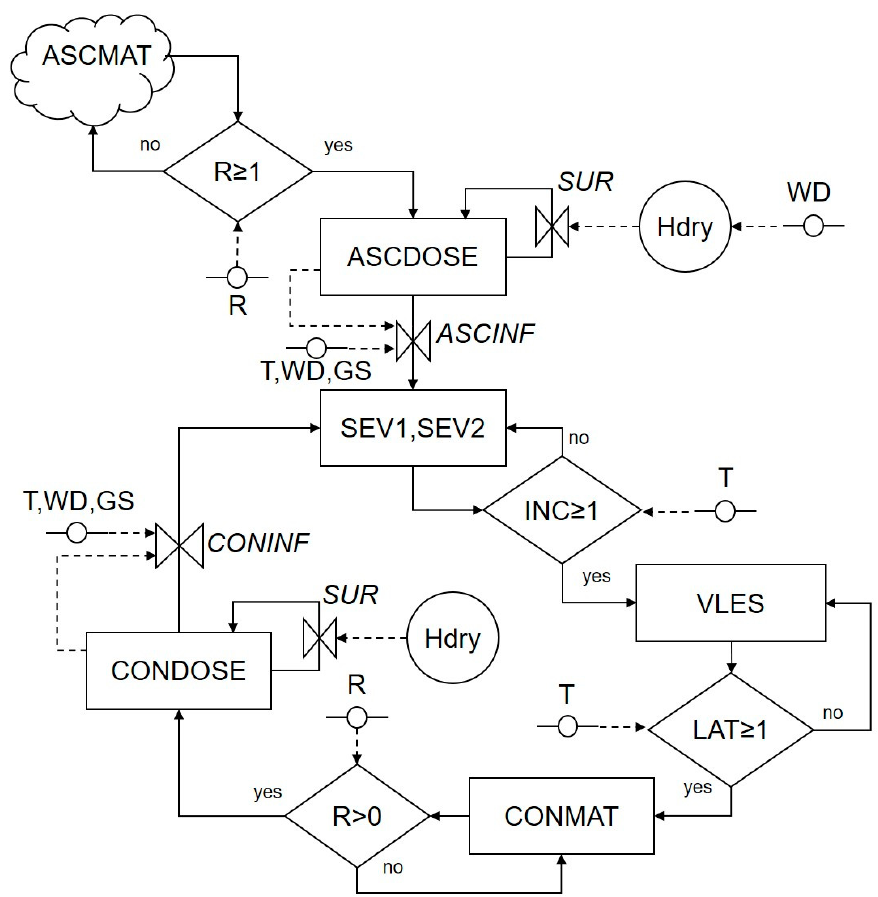
Figure 1. Relational diagram of the life cycle of Ascochyta rabiei . Legend: parameters (R, T, WD, GS); boxes are state variables; solid arrows represent flux and direction of states; dotted arrows represent flux and direction of information; circles symbolize intermediate variables; diamonds are switches; “bow ties” are valves in flux (rates) (see Table 1 for acronym explanations).